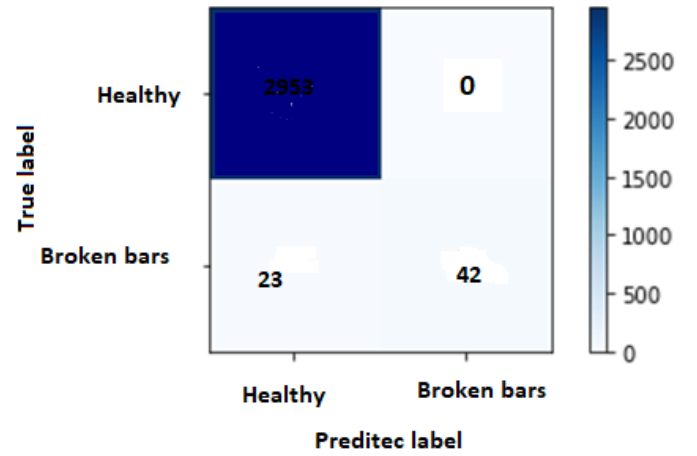
Figure 5. Kmeans (k = 3) model trained with real data.